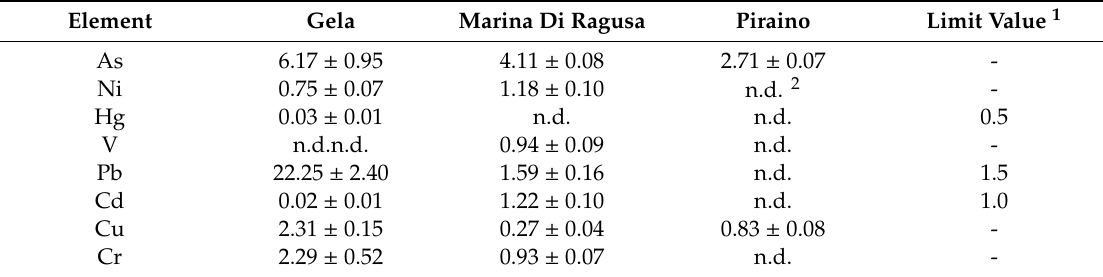
Table 5. Mean values and standard deviation of concentration (mg kg − 1 wet weight) of